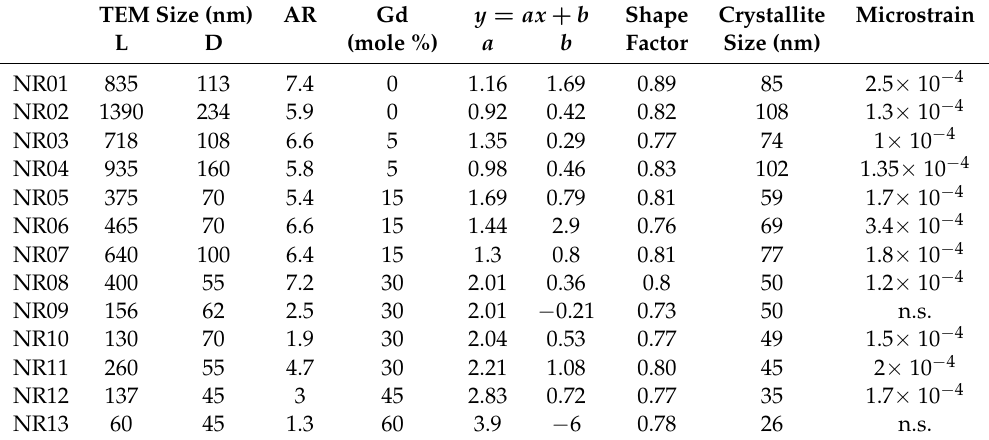
Table 4. Main parameters of the studied NPs (with L for Length, D for Diameter, AR for Aspect Ratio) and the parameters from the Halder-Wagner graph with the apparent size and microstrain obtained for each of them. Here only the expected gadolinium concentration is given. (n.s. negative microstrain even if the value is very close to zero).